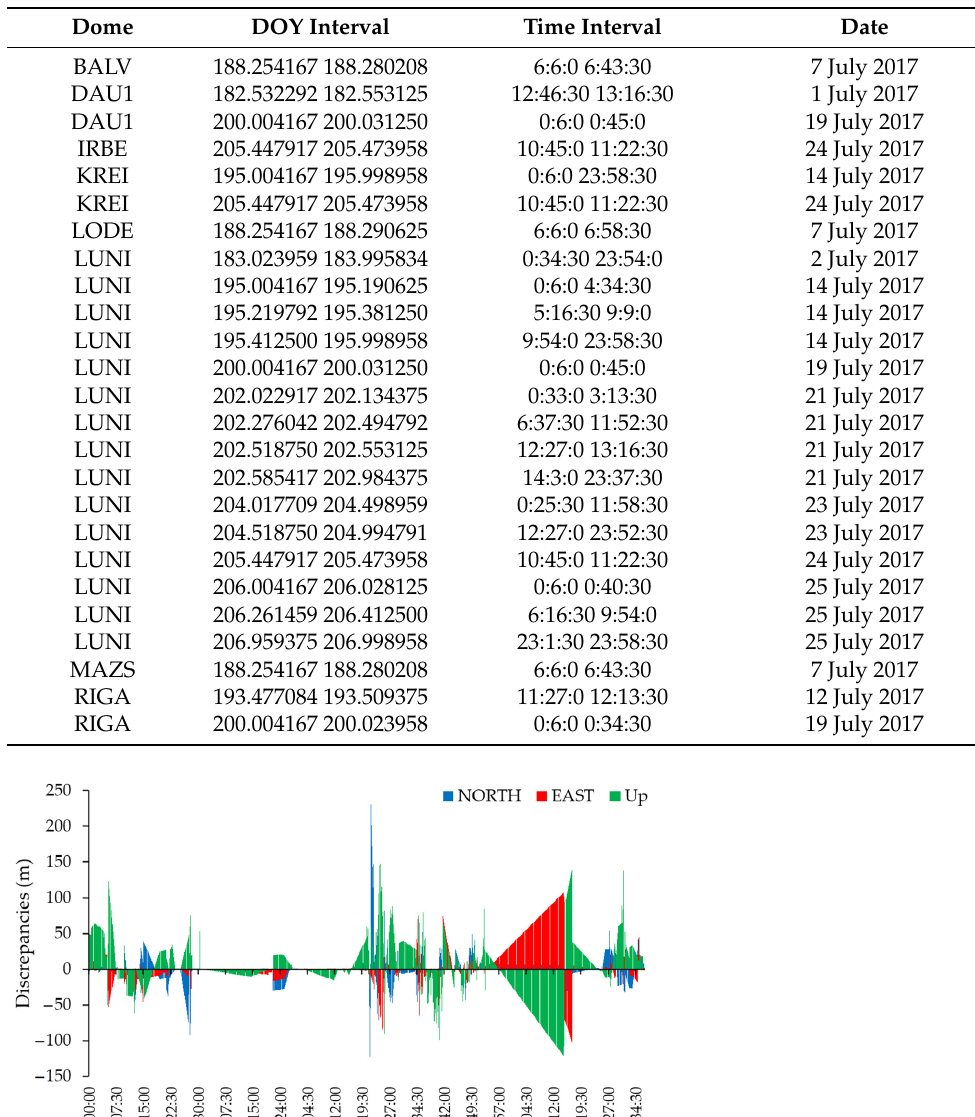
Table 5. Sample List of stations (DOMES), date and time of the sequence of faulty solutions.